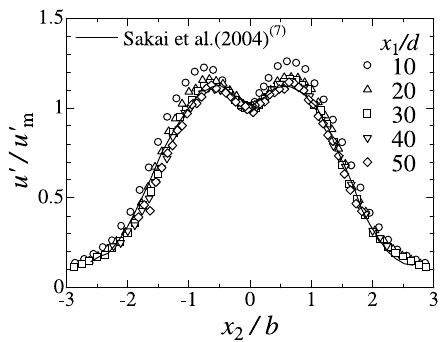
Fig. 13 Cross-streamwise profiles of the r.m.s streamwise velocity